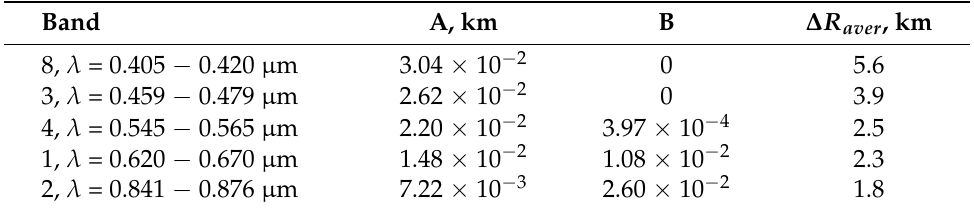
Table 6. Values of approximation constants of Equation (2) and average approximation errors ∆ R aver for the considered